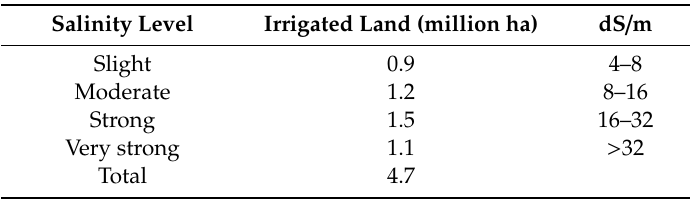
Table 3. Soil salinity level in irrigated lands in Iran.